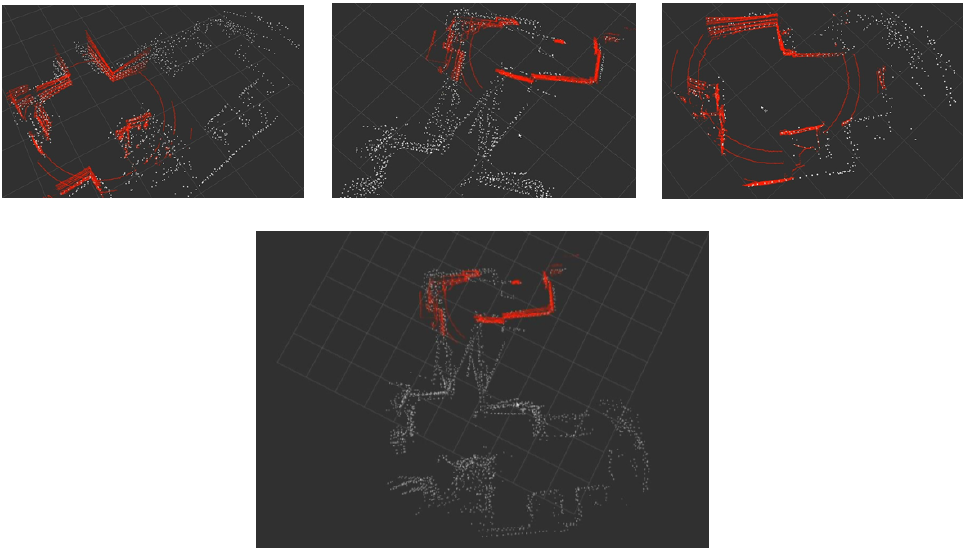
Figure 15. Incremental generation of a 3D map in an indoors application, running eSoC-LAM in a DE1-SoC